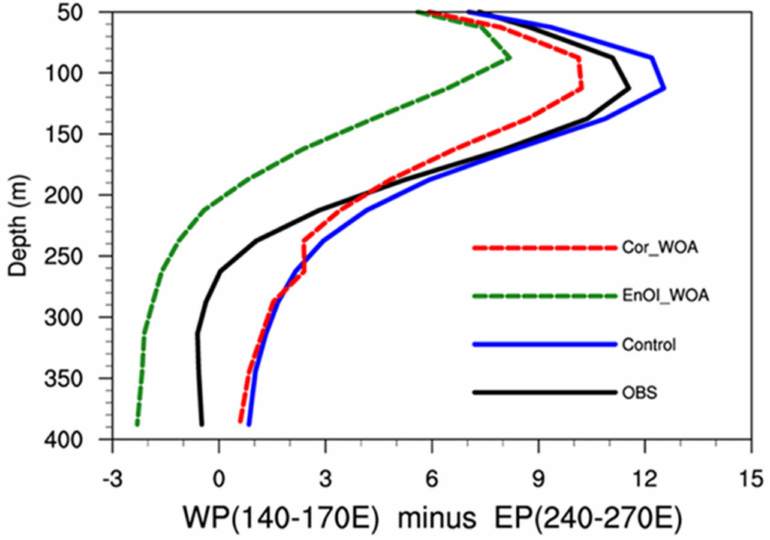
Figure 10. The vertical profile of the difference in sea temperature between the tropical western Pacific ( − 5–5 ◦ N, 140–170 ◦ E) and the eastern Pacific ( − 5–5 ◦ N, 240–270 ◦ E) (unit, ◦ C): black solid, OBS; blue solid, Control; green dashed, EnOI_WOA; red dashed,